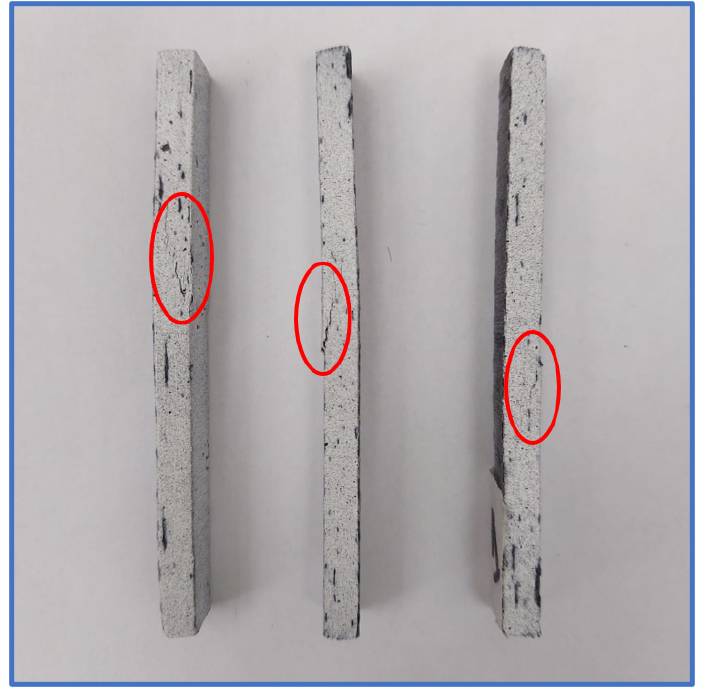
Figure 14. Bending test specimens after testing.